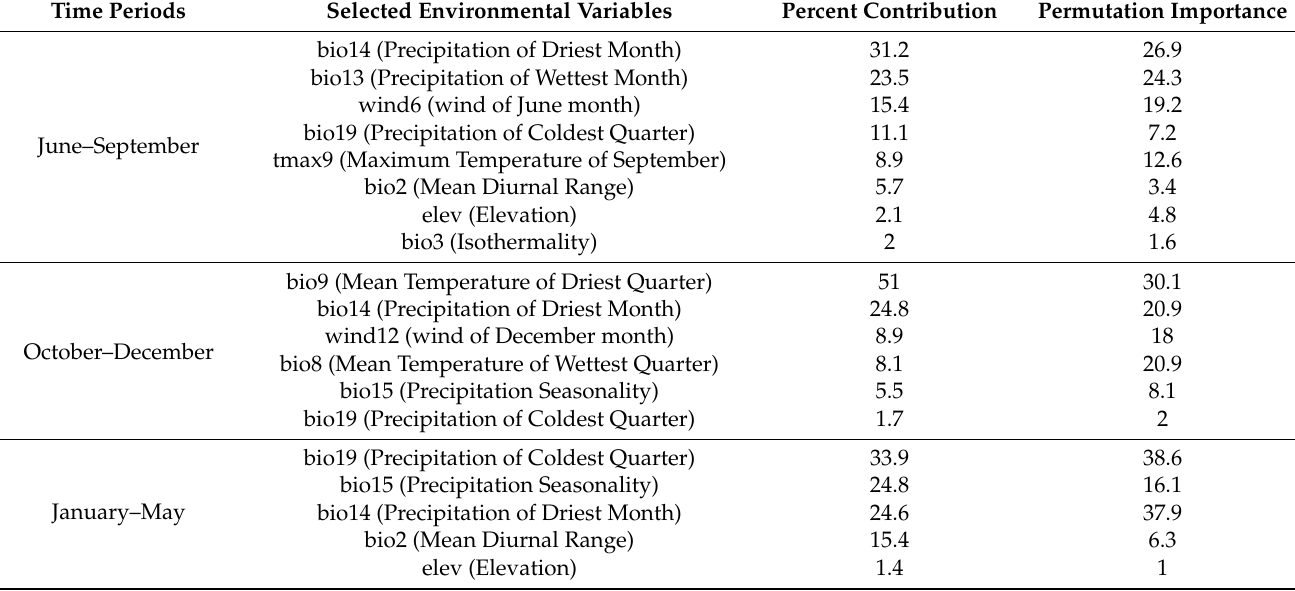
Table 5. Percent contribution and permutation importance of the environmental variables in terms of Africa’s suitability. Time